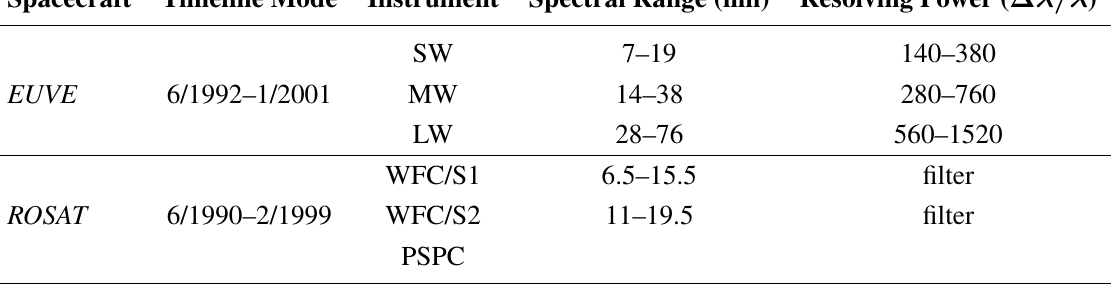
Table 2. Spectroscopic Properties of Extreme-Ultraviolet and X-ray